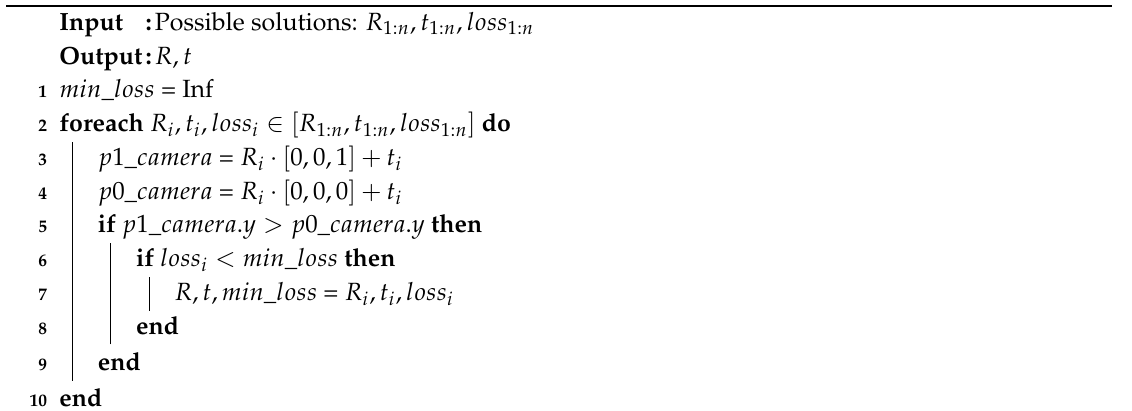
Algorithm 1: Choosing the most suitable solution from possible